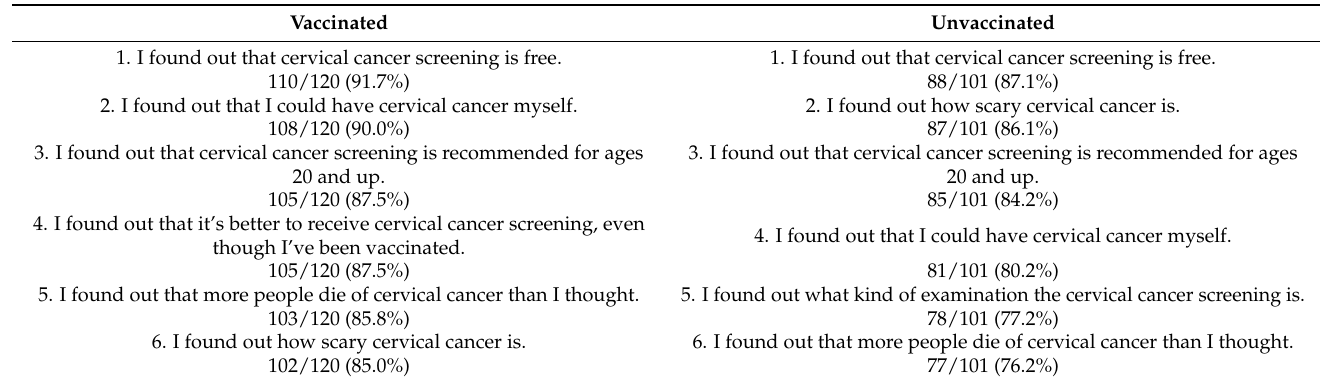
Table 4. Reasons given for enhanced intention to receive cervical cancer screening.